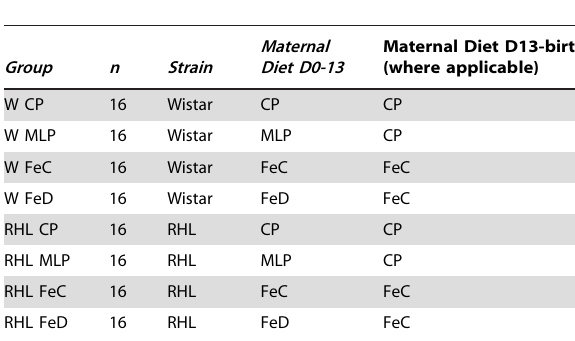
Table 7. Feeding regime of pregnant dams across 8 experimental